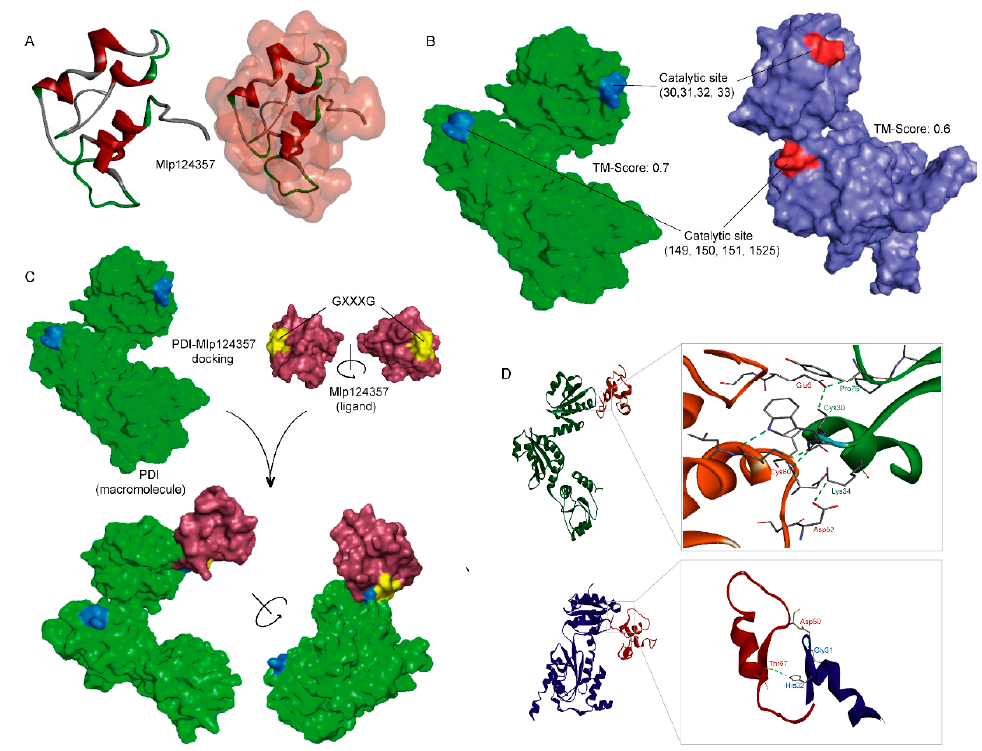
Figure 5. Molecular modeling also supports the association of AtPDI-11 and Mlp124357 effector. ( A ) Ab initio structure of Mlp124357. ( B ) Predicted structure and catalytic sites of PtPDI (left-green) and AtPDI-11 (right-blue). TM-scores have values between 0 and 1, where 1 indicates a perfect match between two structures. ( C ) Functional approach of docking between Mlp124357 and PtPDI. ( D ) The orientation and interactions of PtPDI-Mlp124357 (upper panel) and AtPDI-Mlp124357 (lower panel) complexes.